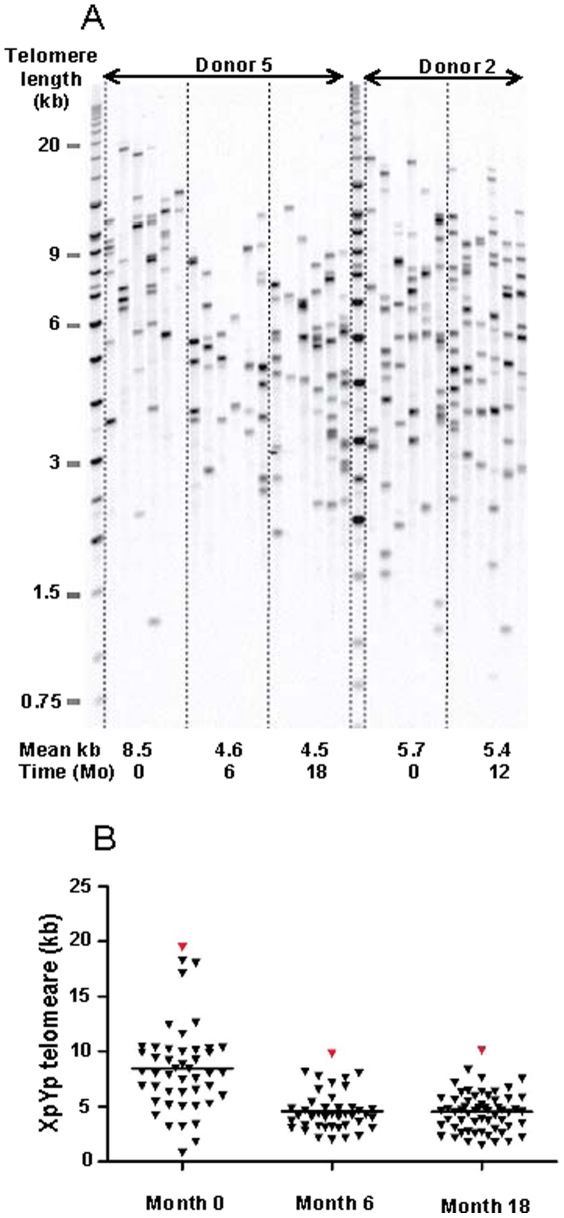
XpYp telomere end distributions in single telomere length analysis (STELA) (6 lanes/sample).A. Comparison between blood donors 5 and 2 (control), showing similar patterns as the results from RT-PCR and Southern blot. The 3 month data for Donor 2 could not be included in the STELA, due to a lack of DNA after the Southern blot analysis. B. The telomere distribution in the samples from Donor 5, showing a considerable decrease in heterogeneity and a loss of the largest telomeres.